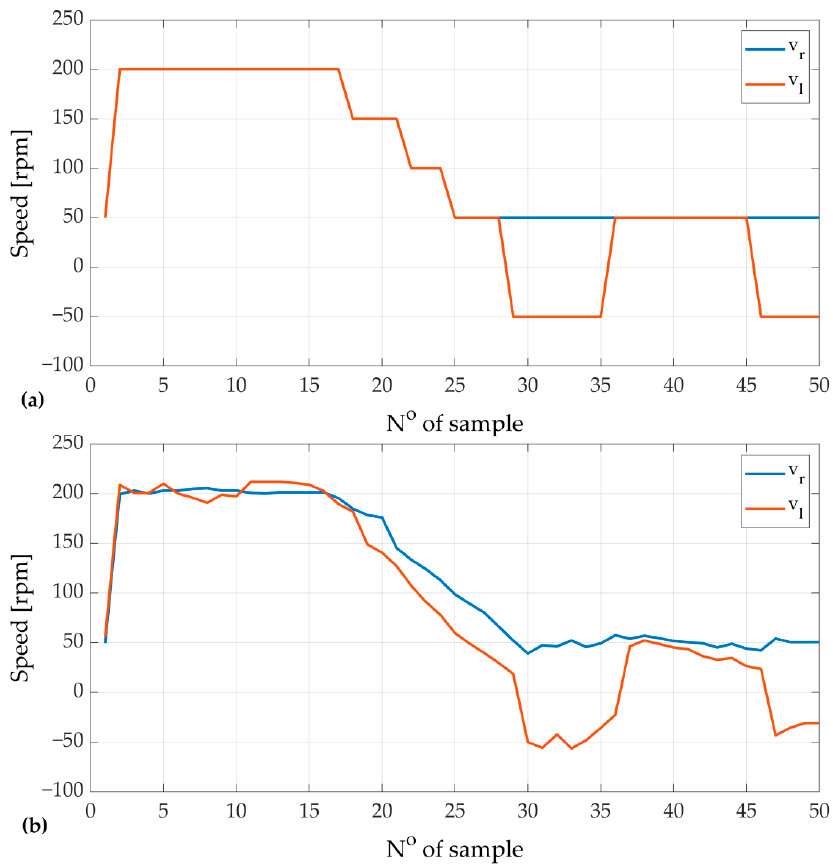
Figure 7. Comparison of reference speeds: ( a ) standard commands (defined by user); ( b ) neural path planner response.